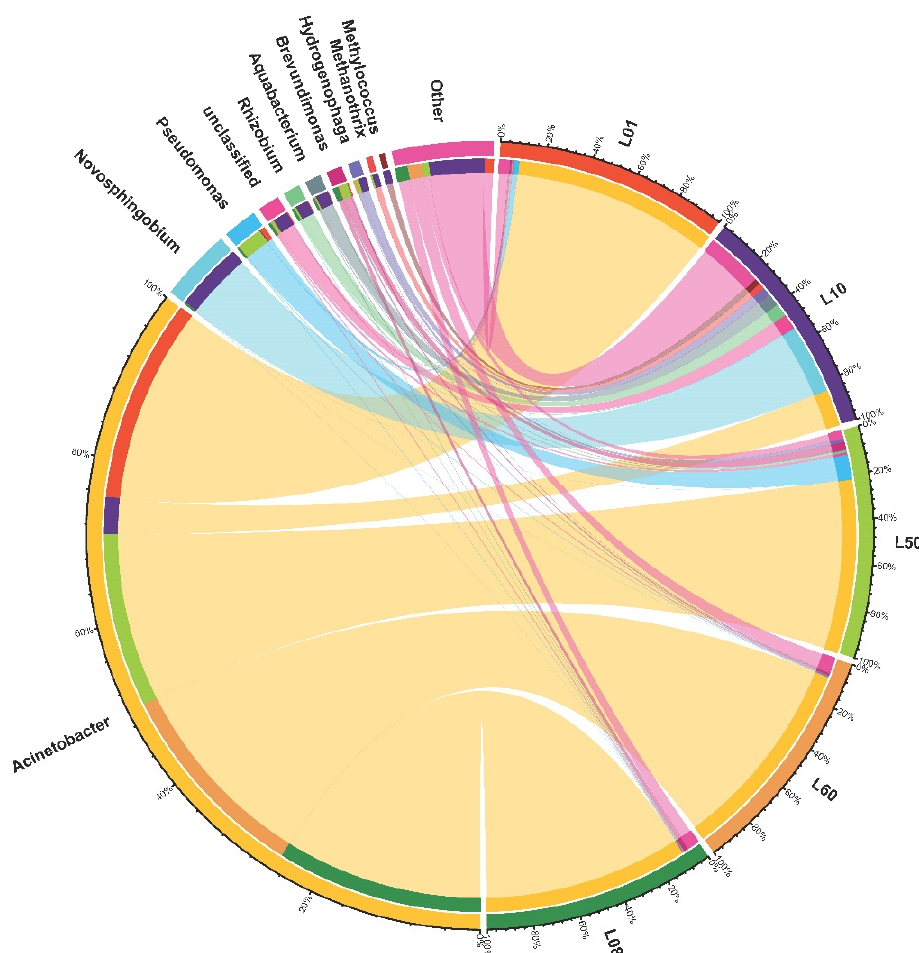
Figure 2. Relationship between samples and taxa of bacterial communities at the genus level.